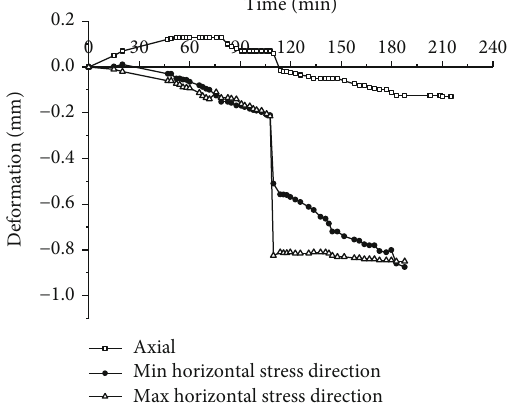
Figure 7: Deformation of the